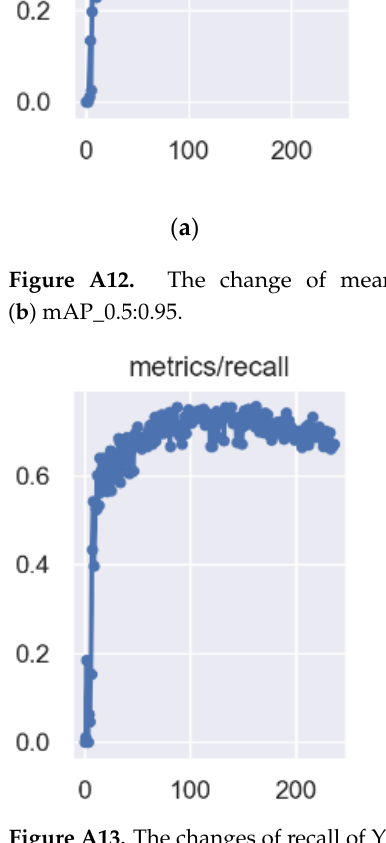
Figure A13. The changes of recall of YOLOV5x.